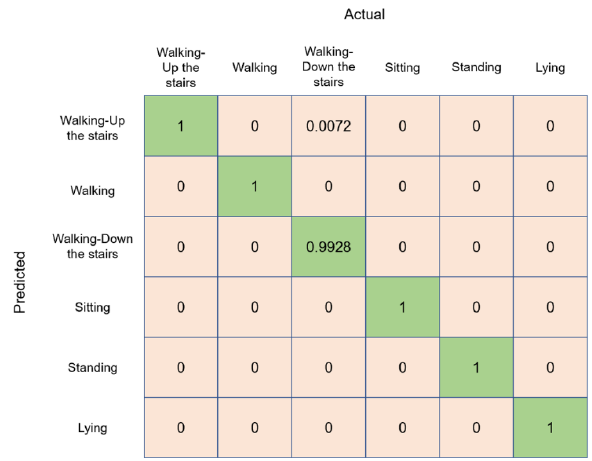
Figure 5. Normalized confusion matrix for the deep learning (DL) algorithm.